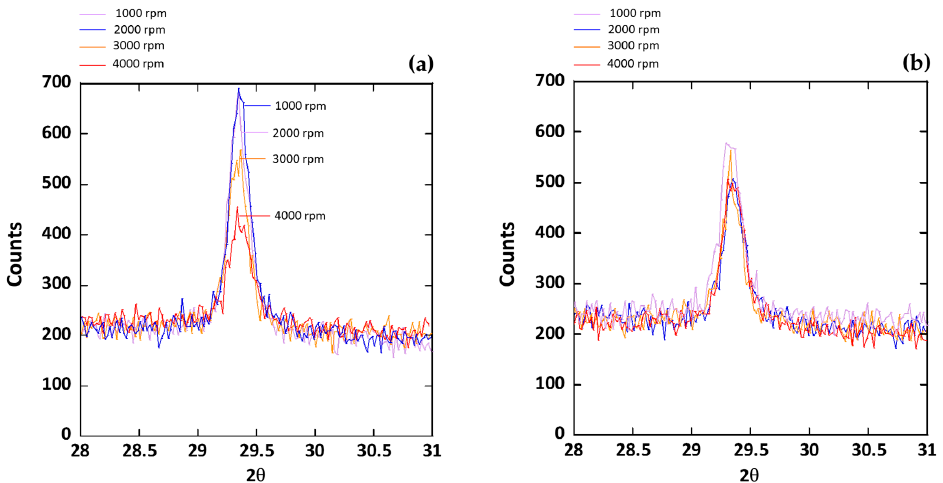
Figure 7. XRD peaks of calcite (104) of cenospheres collected by centrifugal method using the centrifugal speeds of 1000, 2000, 3000, and 4000 rpm, and the centrifugal times of ( a ) 10 min and ( b ) 30 min. Variation of calcite crystallite size with process parameters was found in another sys- tem. In the sink-float system without the centrifugation effect, using the same fly ash-to- medium ratio (1:10) but prolonged soaking time (48 h) resulted in the average CaCO 3 (104) crystallite size of 62.2 nm, which is 29.6% larger in size compared to that of the centrifugal method. Nonetheless, this finding revealed that the growth of CaCO 3 on cenosphere par- ticles was on the same specific growth sites, calcite (104) surface. A further attempt was made to consider the effect of fly ash concentration on calcite crystallite size by varying fly ash content in water; see the result in Figure 8b as variation of CaCO 3 crystallite size was obtained between ~25 to 80 nm. The crystallite size tended to decrease from ~80 nm, then drastically from ~65 nm to ~30 nm, with the increased fly ash content from 10% to 20%, respectively. Figure 8. Average crystallite sizes of calcite (104) contained in cenospheres collected by ( a ) centrifugal method at different centrifugal speeds and times using 10 wt.% fly ash content (1:10 fly ash-to-medium ratio) and ( b ) sink-float method at different fly ash contents and fixed soaking time at 48 h.